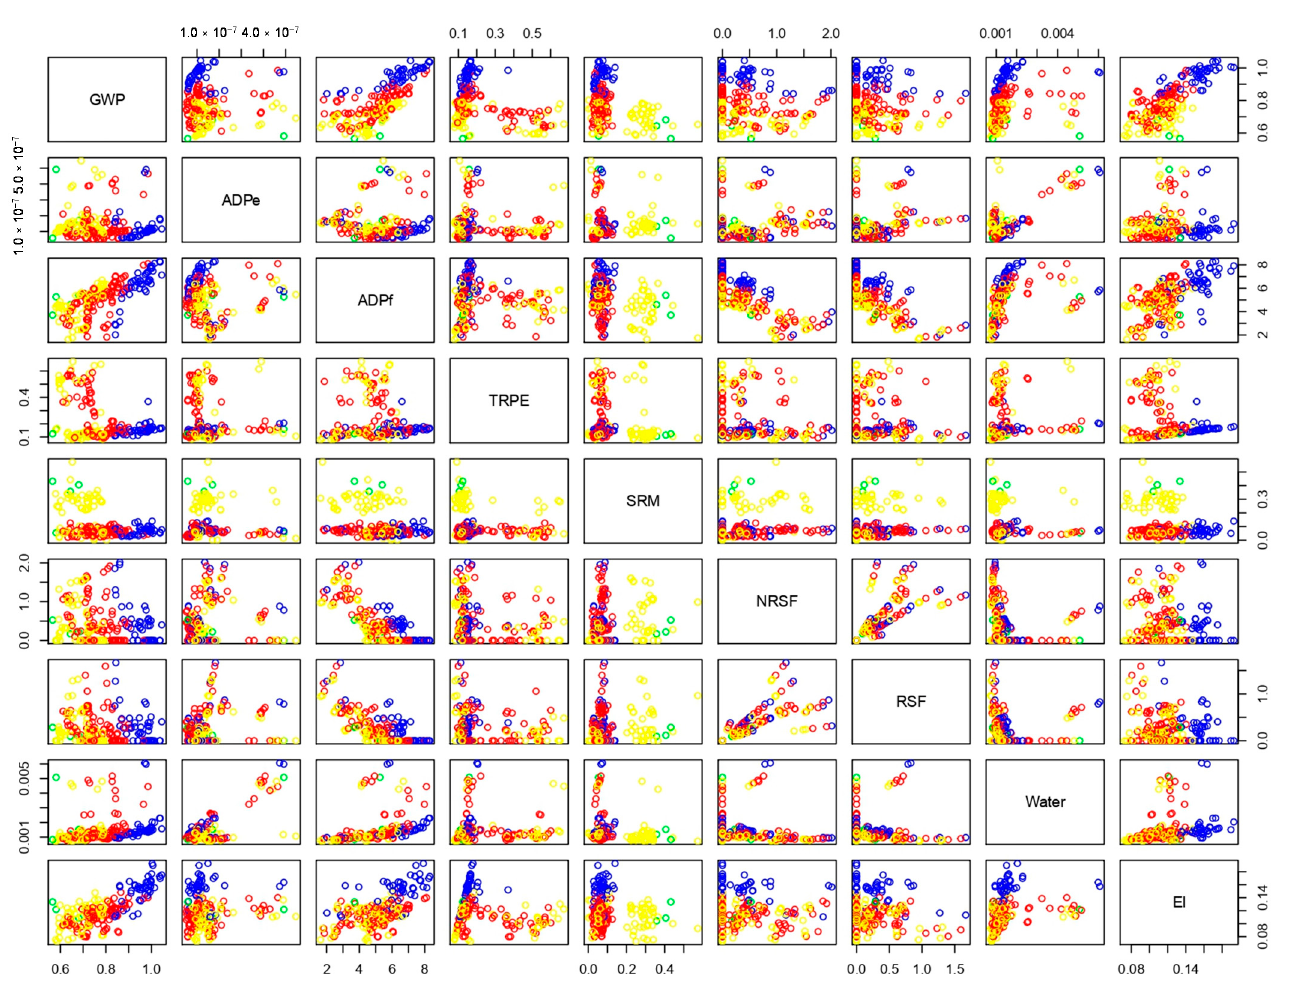
Figure 6. Data and types of cement. (CEM I = blue, CEM II = red, CEM III = green, CEM IV = yellow).